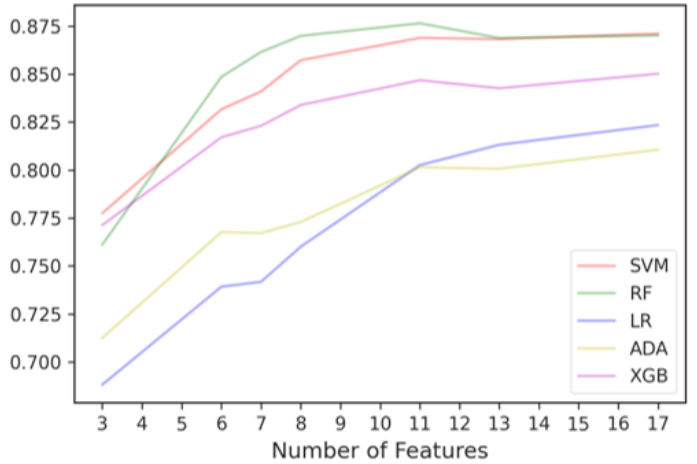
Figure 8. Classification performance curve from adding important features selected by ENET batch- by-batch.